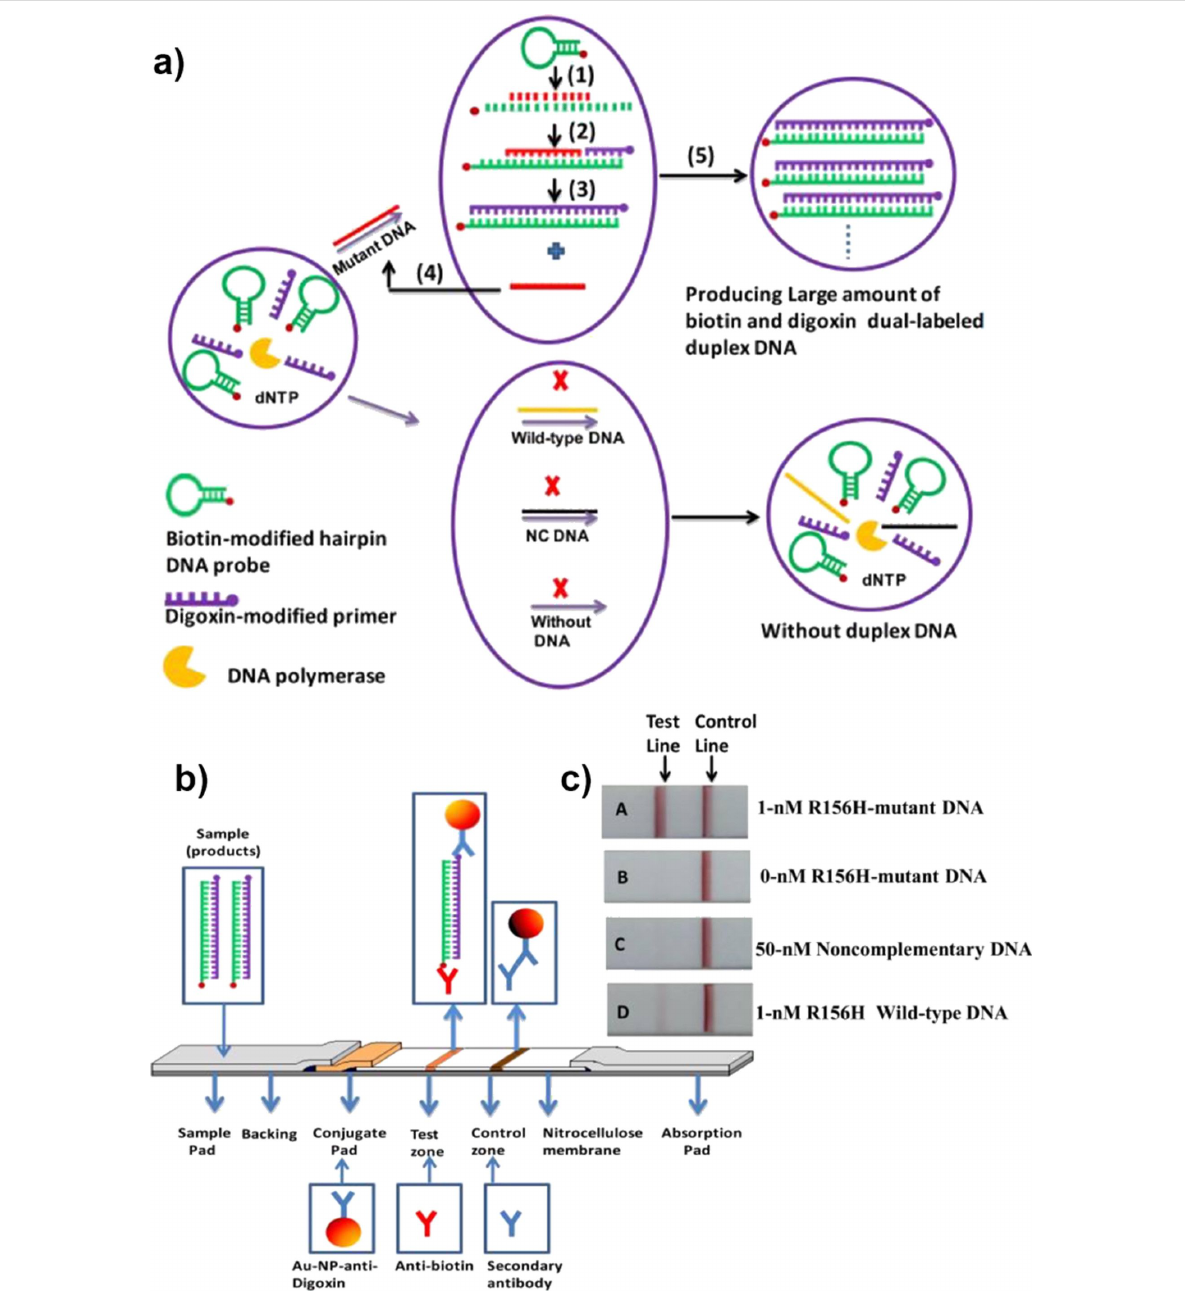
Figure 10: The combination of isothermal strand-displacement polymerase reactions and lateral flow strip for visual detection of gene mutations. a) Schematic illustration of isothermal strand-displacement polymerase reactions and the formation of digoxin- and biotin- attached duplex DNA com- plexes b) The mechanism of detection on lateral flow strip and c) visualization of the presence of mutation. Reprinted with permission from [102], copyright 2012 Elsevier.